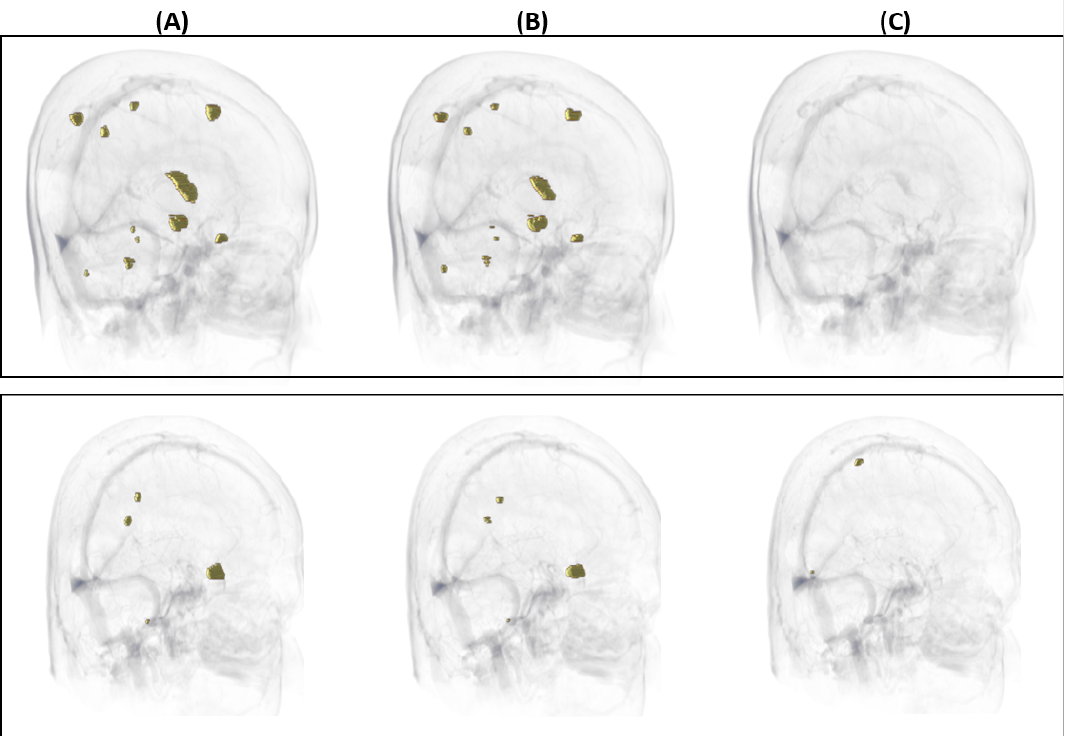
Figure 3. Three-dimensional visualization of the results. The first row represents an example of a case where false positives were not found, and all 11 BM were detected. In the second row, all 4 BM were detected, but 2 false positives were found. Each column represents the ground-truth gross tumor volume delineated manually ( A ), true positives from prediction ( B ), and false positives from prediction ( C